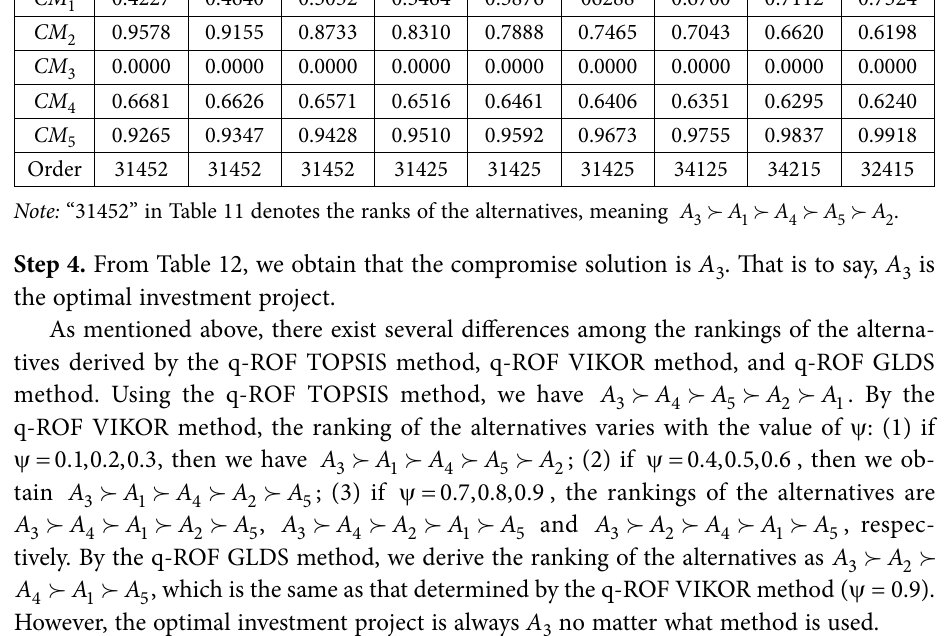
Table 12. Values of the compromise measure with different values of y y = 0.1